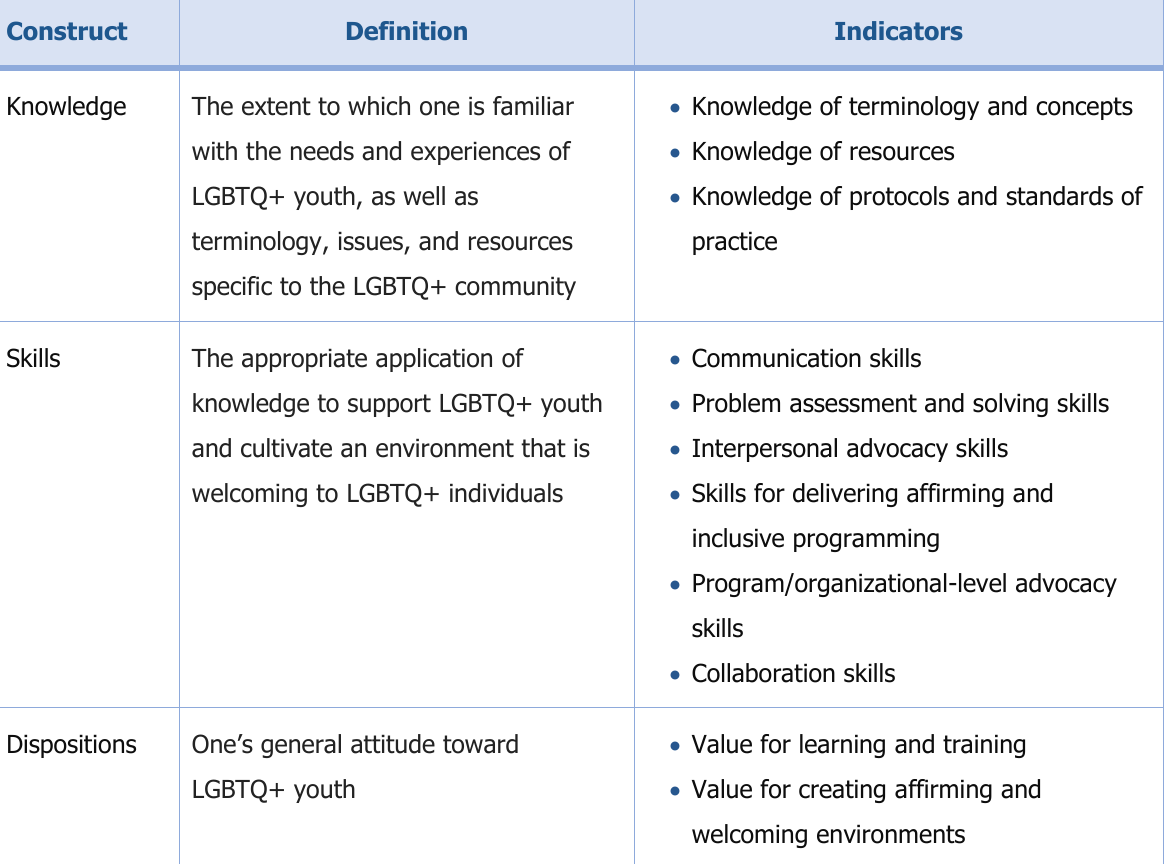
Table 1. Knowledge, Skills, and Dispositions as Applied to LGBTQ+ Youth